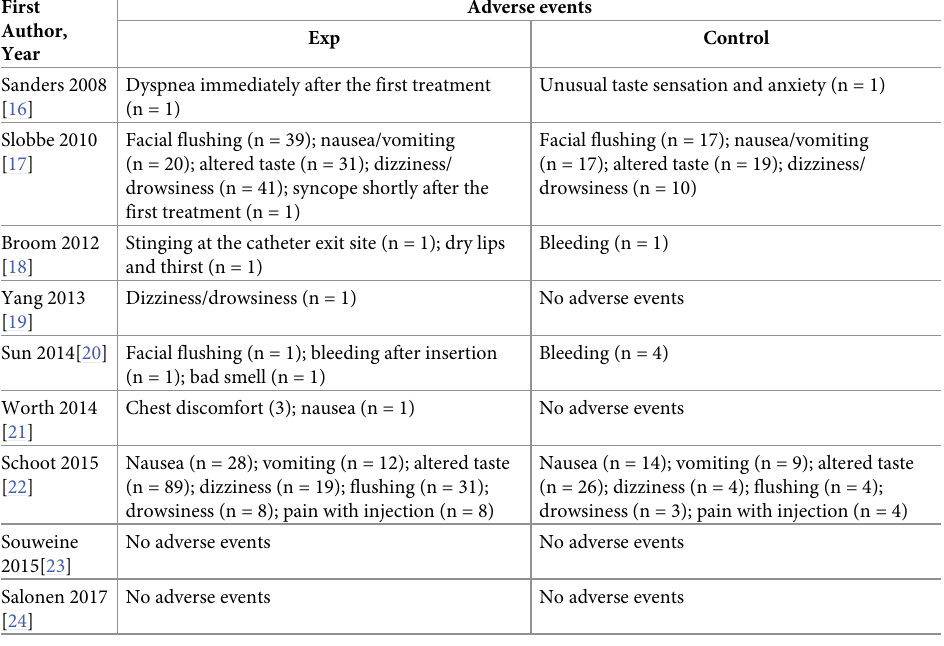
Table 4. Adverse events reported in the included